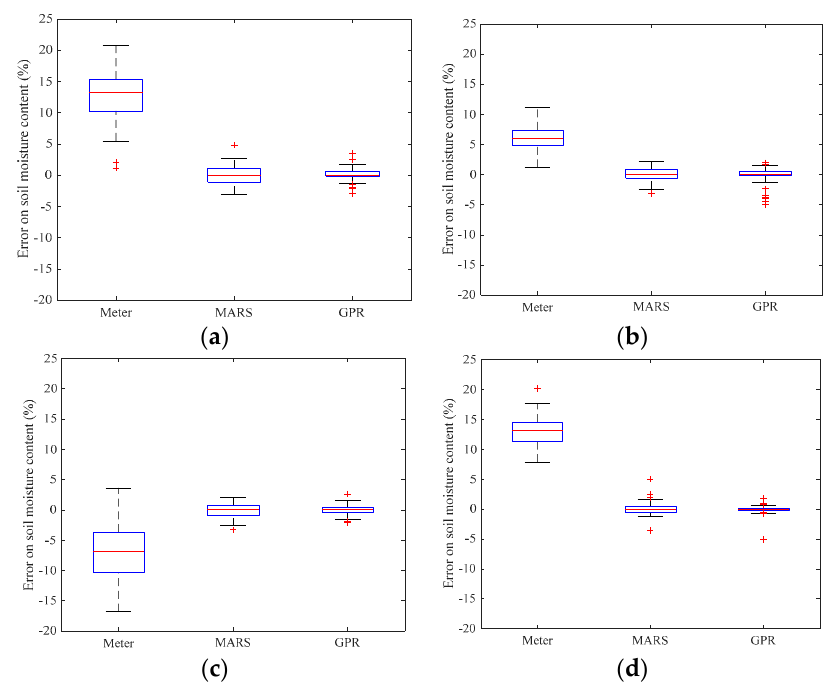
Figure 3. Box plots of the bias error: ( a ) sensor A; ( b ) sensor B; ( c ) sensor C; and ( d ) sensor D.